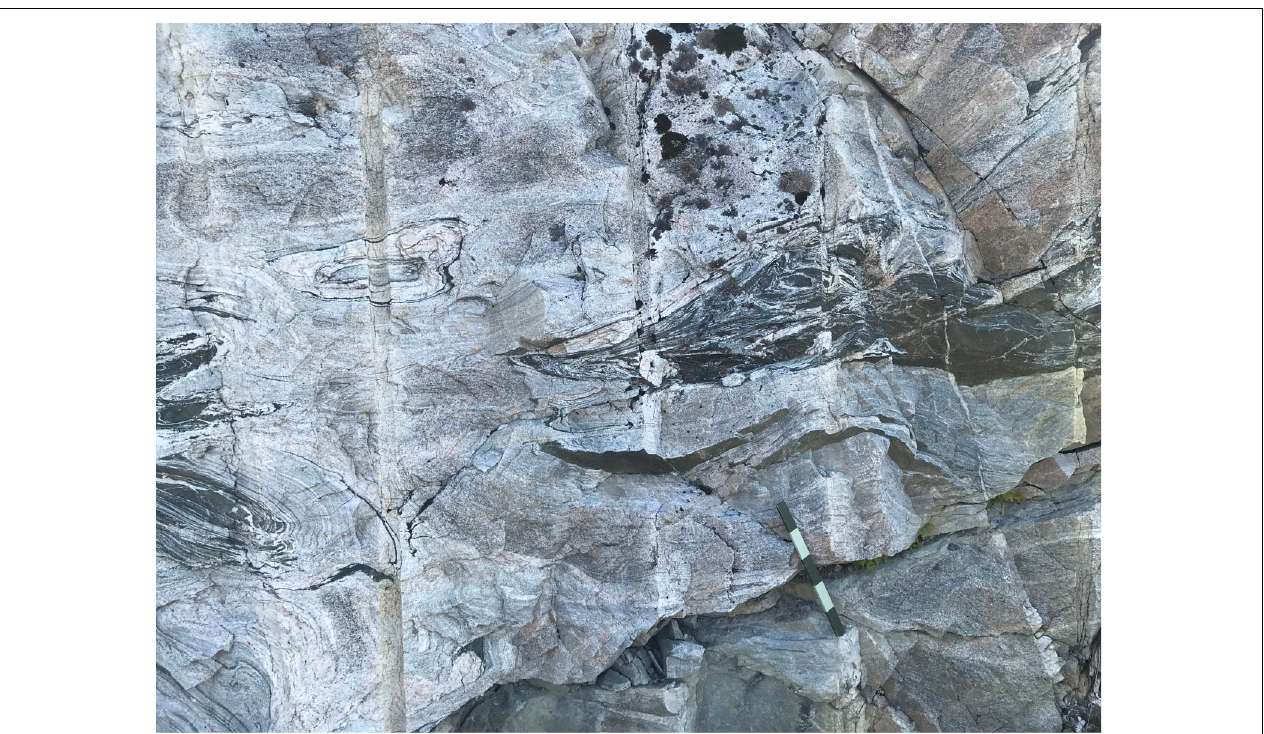
FIGURE 13 | Vestiges of metatexite in diatexite, Kvaløya, northern Norway, West Troms Basement Complex (same outcrop as in Figure 5 ). Note the almost completely melted small raft on the left. Length of scale 50 cm.